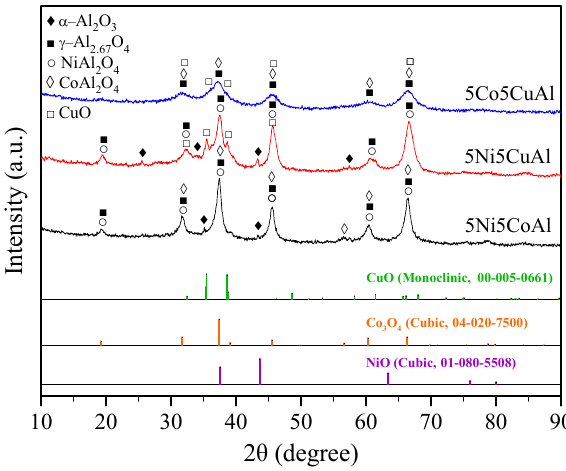
Figure 1. XRD patterns of the 5M5MAl catalyst samples.